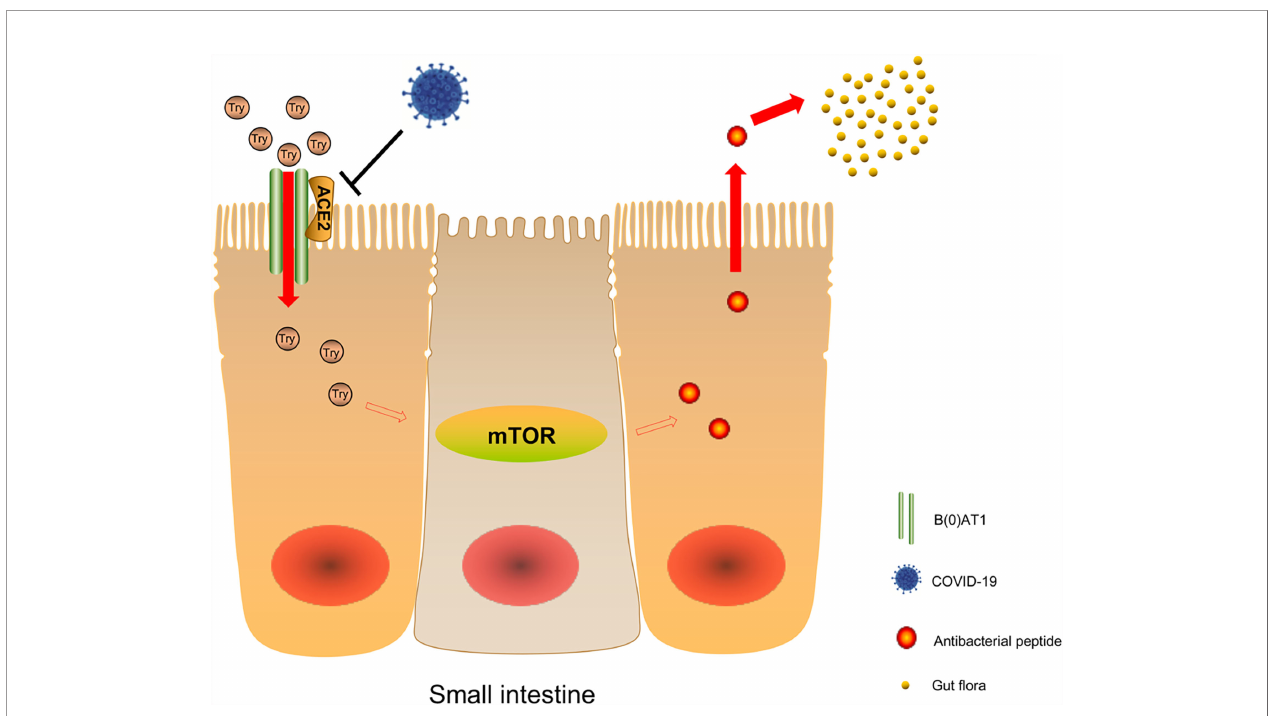
FIGURE 2 | Possible mechanism of COVID-19 affecting intestinal microbiota. Sodium-dependent neutral amino acid transporter B(0)AT1 is expressed in small intestinal cells and plays an important role in amino acid absorption, while the expression and function of B(0)AT1 depend on the existence of ACE2. After viral infection, the decrease of ACE2 expression will lead to the decrease of B(0)AT1 expression, and dietary tryptophan is mainly absorbed through the B0AT1/ACE2 transport pathway on the surface of the small intestine epithelium, resulting in a signi fi cant decrease in plasma tryptophan levels, and lack of tryptophan and its metabolite nicotinamide leads to a decrease in mTOR pathway activity, which affects the expression of antibacterial peptides in the intestinal fl